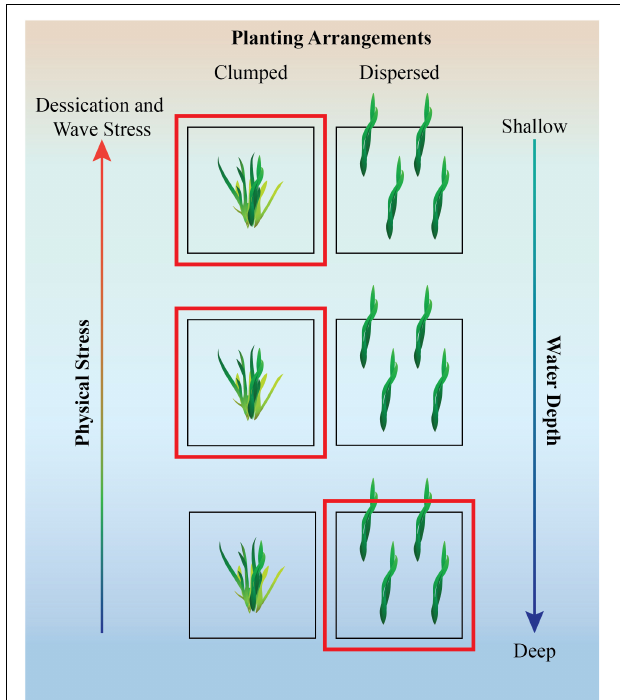
FIGURE 2 | Illustration of experimental design and hypothesis of planting design for seagrass along stress gradients. Hypothesized beneficial planting method is denoted by the red box. In a low stress environment, dispersed planting method may work well but in the face of environmental stress, clumped planting is likely to alleviate some stress via neighbor facilitation (Silliman et al., 2015). Figure inspired by a figure in Renzi et al. (2019).